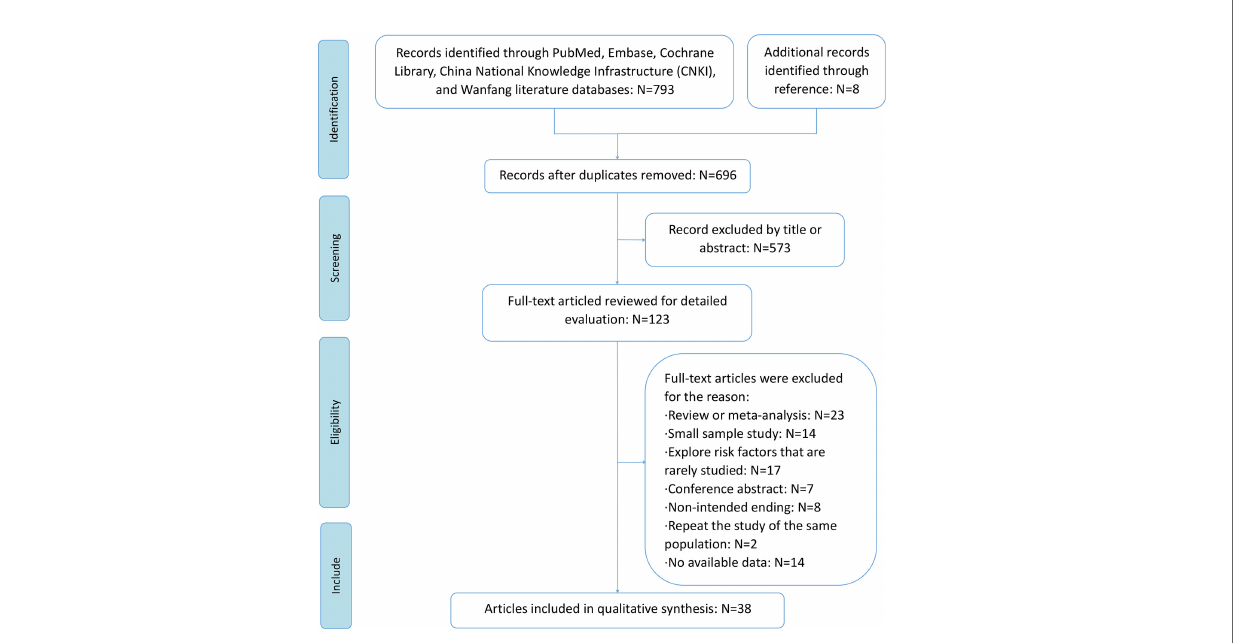
FIGURE 1 | The fl owchart of the literature